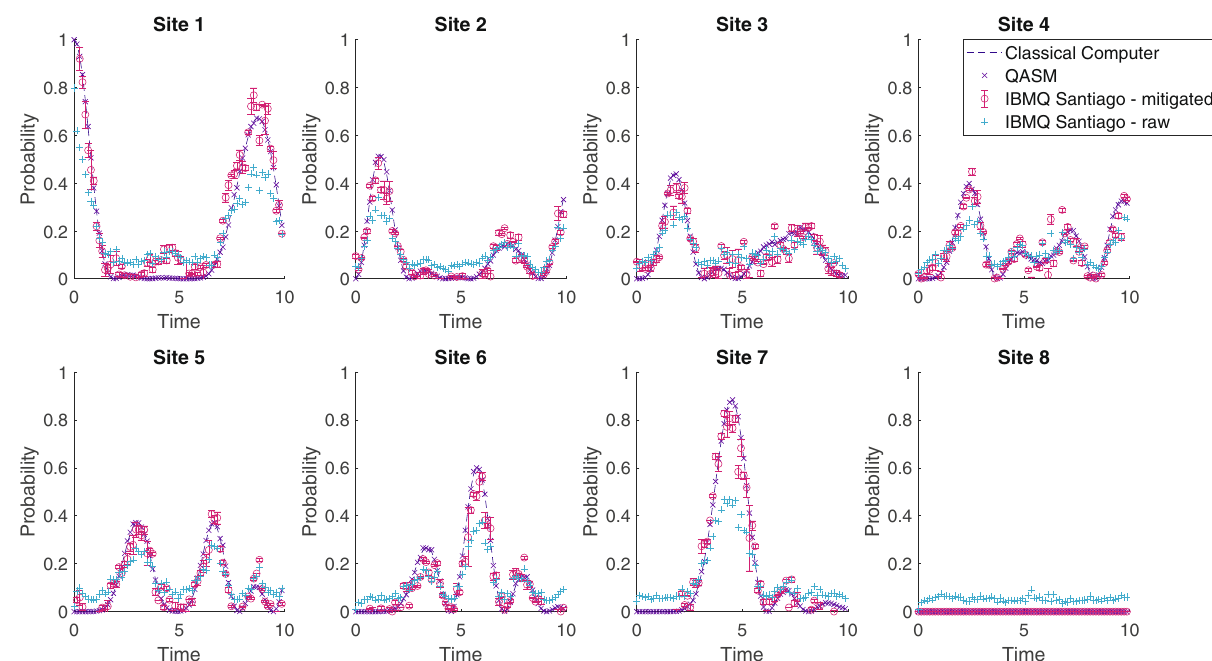
Fig. 2 Unitary evolution in an ordered one-dimensional chain with nearest-neighbour coupling in a channel with seven sites. The evolution is discretized into 75 points and site 1 is used as the initial state. Each point is an average over three jobs of 8192 shots each. The error bars are deduced from the discrepancies between the three jobs. The results of the IBM Quantum Assembly Language (QASM) simulator are consistent with the classical simulation, as expected. Due to the method, we use to mitigate noise, some points are below the horizon and are set to 0. A nearly time-independent error is observed in site 8, con fi rming the validity of the noise model. The standard deviation of the mitigated data from the classical simulation is 0.06. Time is in arbitrary units